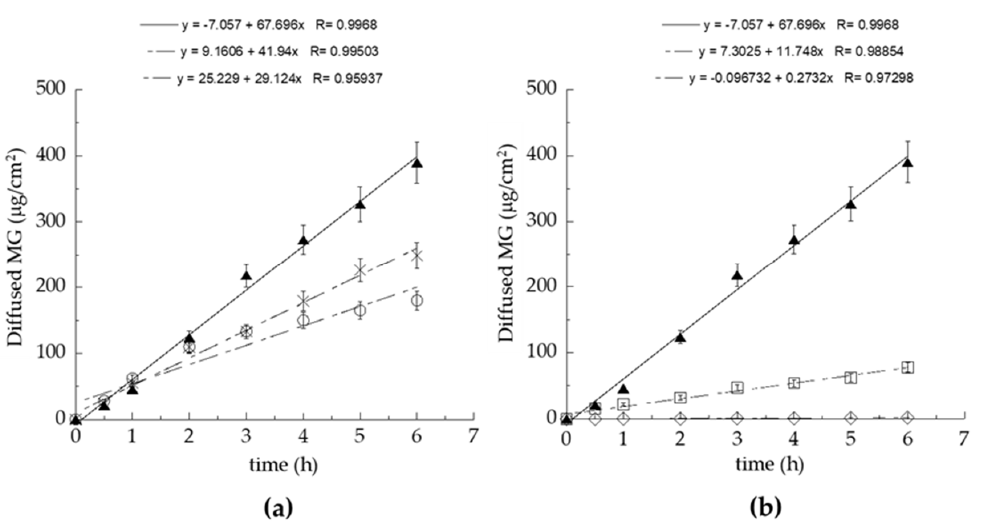
Figure 4. Effect of membranes ( a ) and receiving phases ( b ) on MG diffusion kinetics. Experiments were performed using Franz cells. ( a ) nylon ( ), MCE ( × ), PTFE ( o ) membranes and ethanol/water 50:50, v/v as receiving phase; ( b ) ethanol/water 50:50, v/v ( ), ethanol/water 30:70, v/v ( □ ), water ( ◊ ) as receiving phases and nylon as membrane. Data are the mean of 6 independent experiments ± s.d.